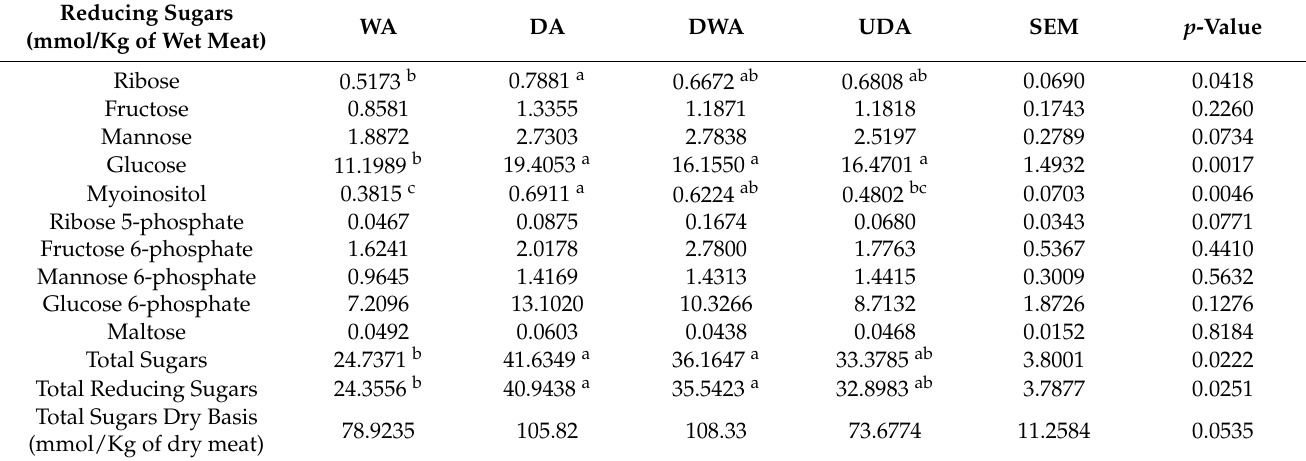
Table 2. Effect of different aging methods on the sugar concentration of cull cow beef loins ( M. longis- simus lumborum ) after 28 days of aging.